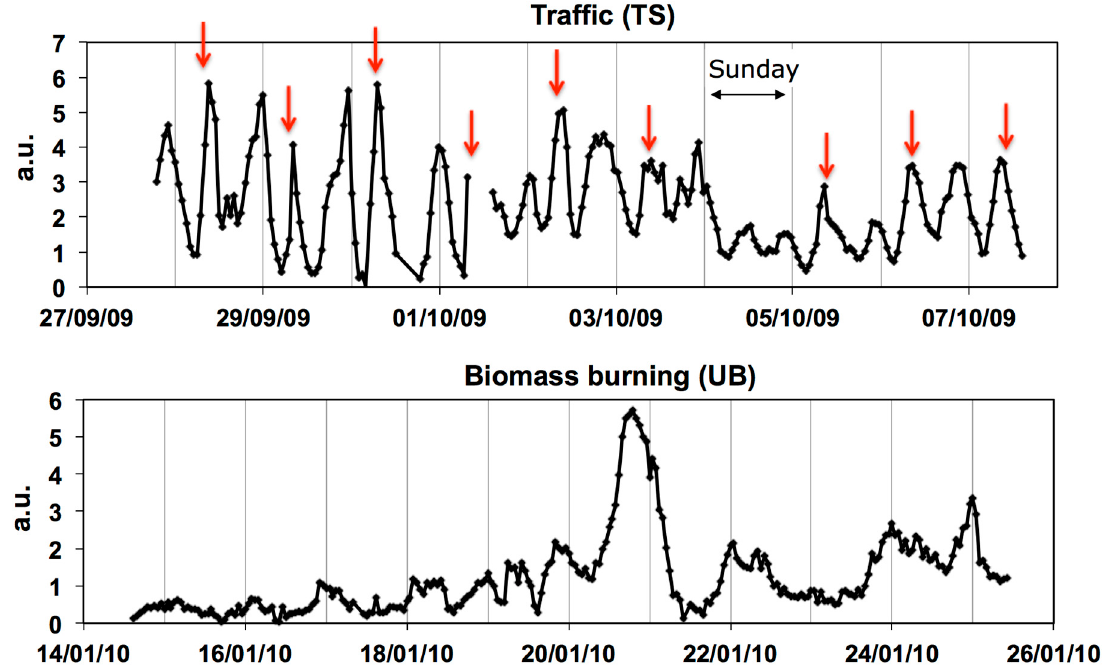
Figure 9. Hourly time trend of the traffic source (at the TS site, during the autumn intensive field campaign) and of the biomass burning source (at the UB site during the winter intensive field campaign). Vertical bars correspond to midnight, while red arrows are positioned at ~ 8:00 a.m. Gaps are due to sampler malfunctioning.